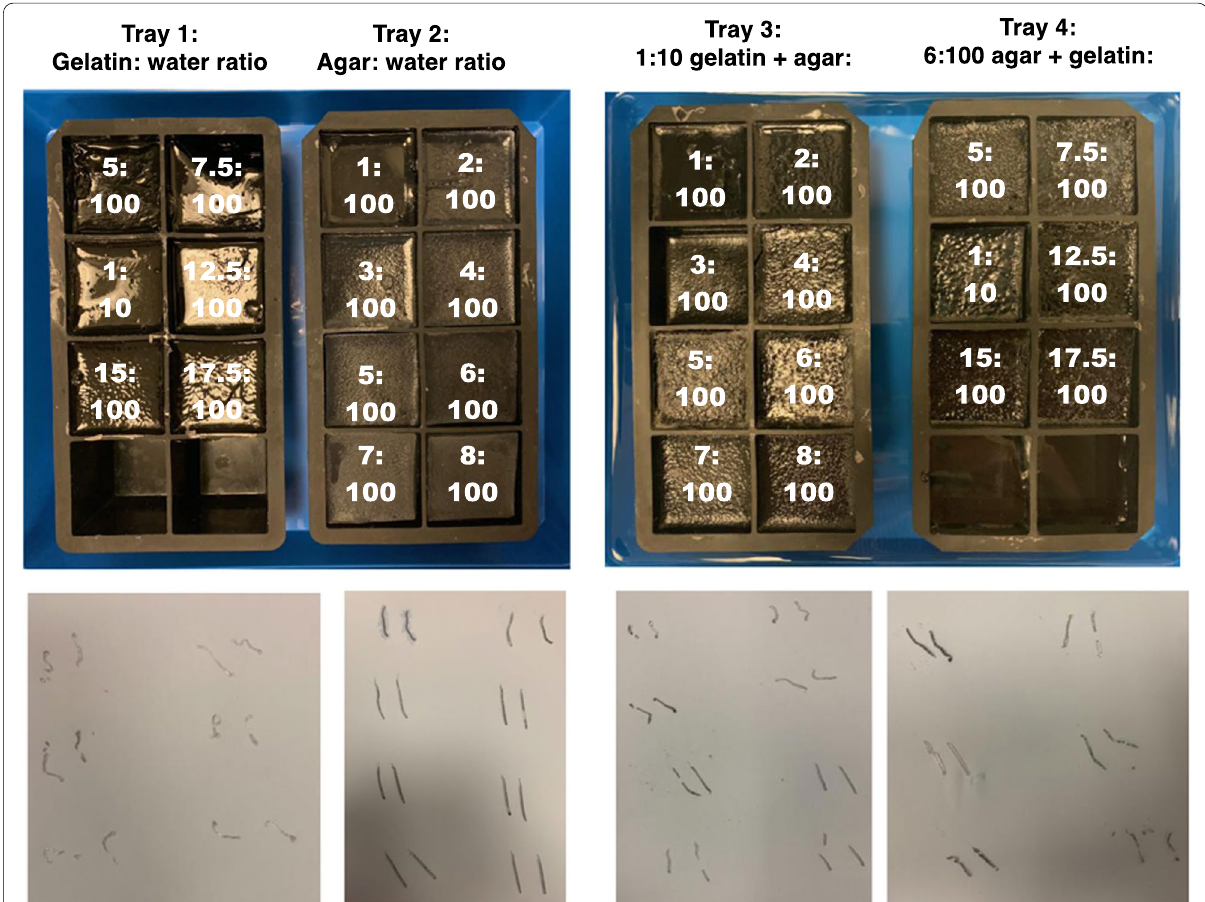
Fig. 1 Concentrations and core adequacy of gelatin, agar, and mixed gelatin/agar samples. Concentrations (shown as white text overlaid on images) denote ratios of gelatin or agar to water, by weight ratio. Mixed gelatin/agar samples contain equal volumes of gelatin and agar solutions at specified concentrations. Biopsy samples taken on day 1 are shown below each